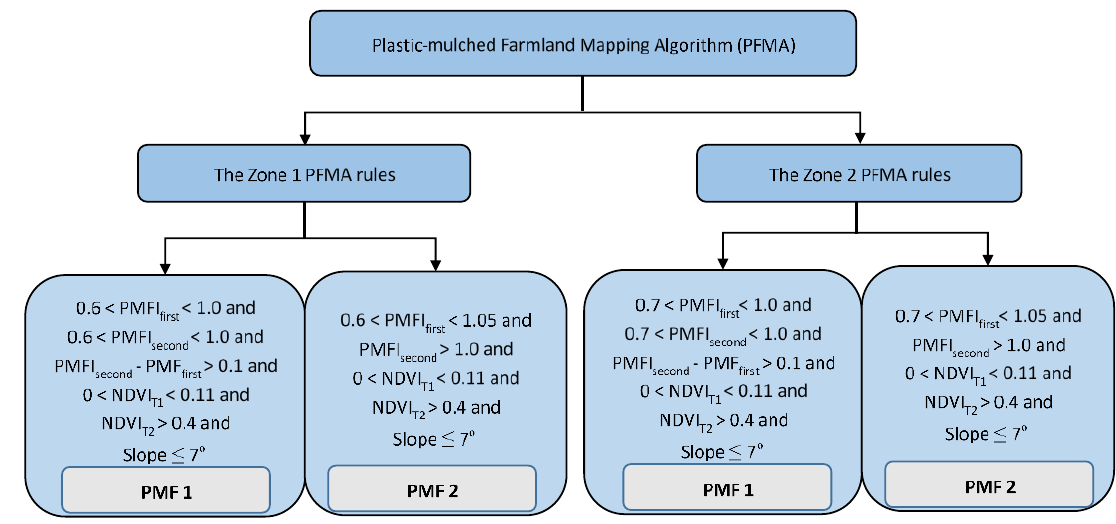
Figure 6. The PFMA established for each zone.